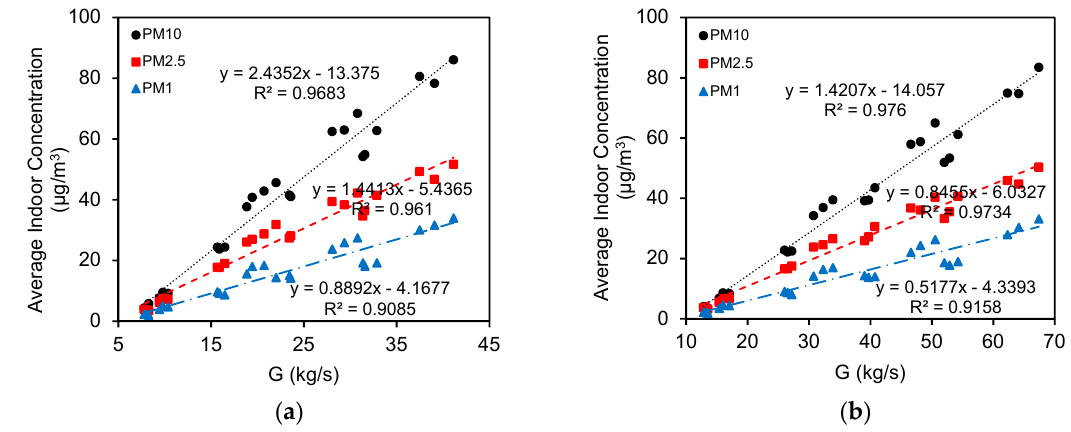
Figure 15. Relationships between G and average indoor particle concentrations when wall porosities are 3.5% ( a ) and 7.0% ( b ), respectively.